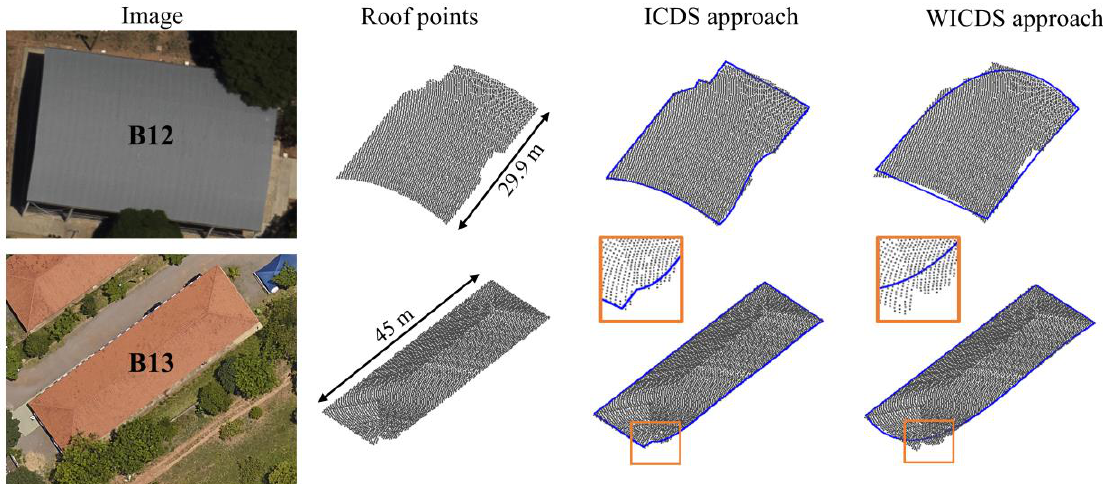
Figure 14. Occlusions at building corners caused by nearby trees. Building with curved segments ( first row ). Building with straight-line segments ( second row ). For both buildings, we show aerial image patches, roof points, and modeled boundaries. The orange rectangles highlight the corner region in B13 where the occlusion occurs.